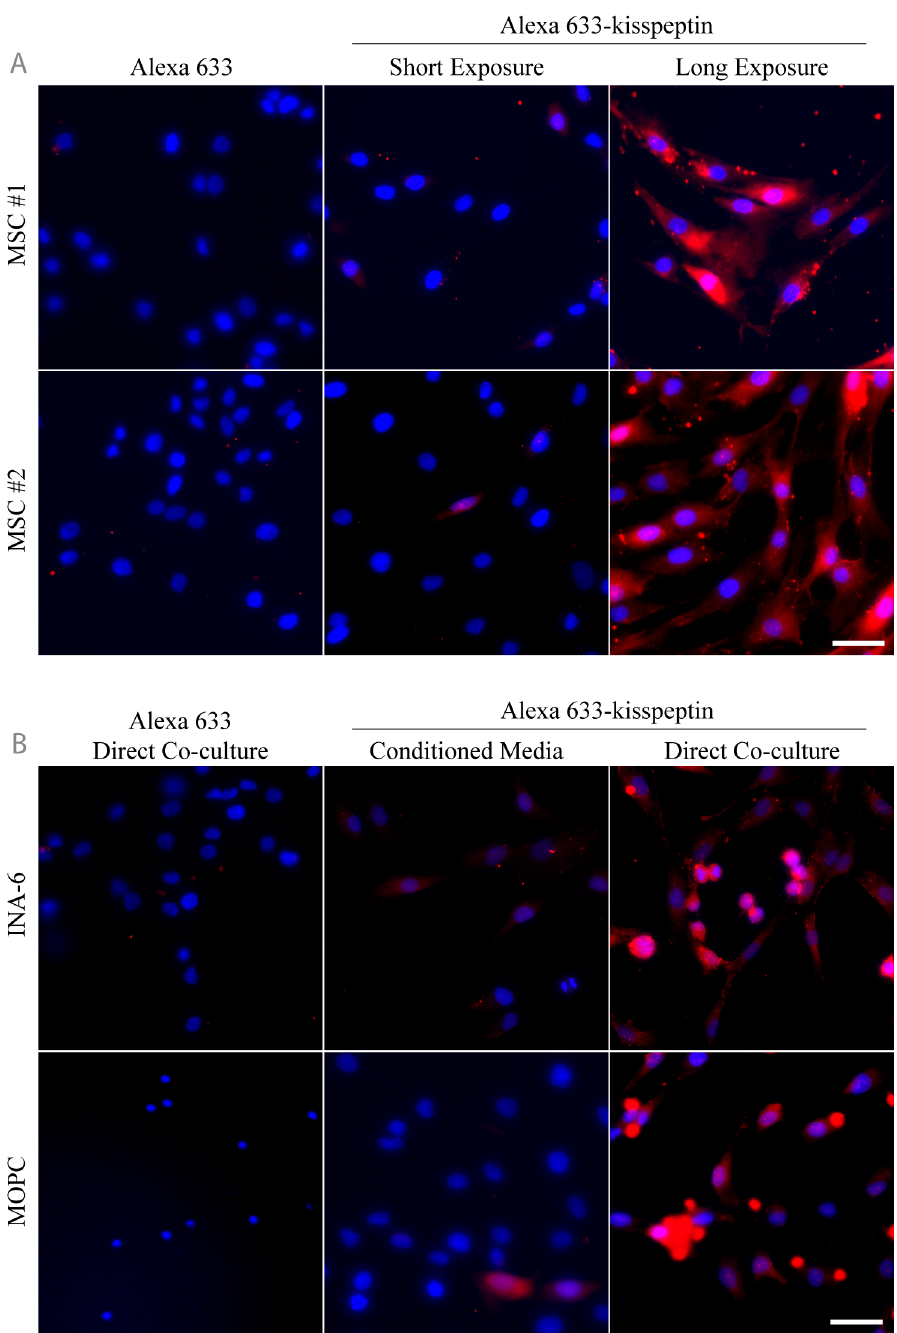
Fig 4. Alexa 633-kisspeptin binding to MSCs increases after direct co-culture with either human or mouse-derived MM cells. Primary MSCs from two different donors were incubated with Alexa 633-kisspeptin or the unconjugated dye and imaged with fluorescence microscopy (A). Dye shows heterogeneous, low level binding to MSCs in a kisspeptin-dependent manner. MSCs were incubated for 24 h with either MM cell line-derived media (conditioned media) or were directly co-cultured for 24 h with INA-6 cells or MOPC cells (B). Binding of the Alexa 633-kisspeptin probe required direct co-culture, while the free dye failed to show any specific binding. Bar = 50 μ